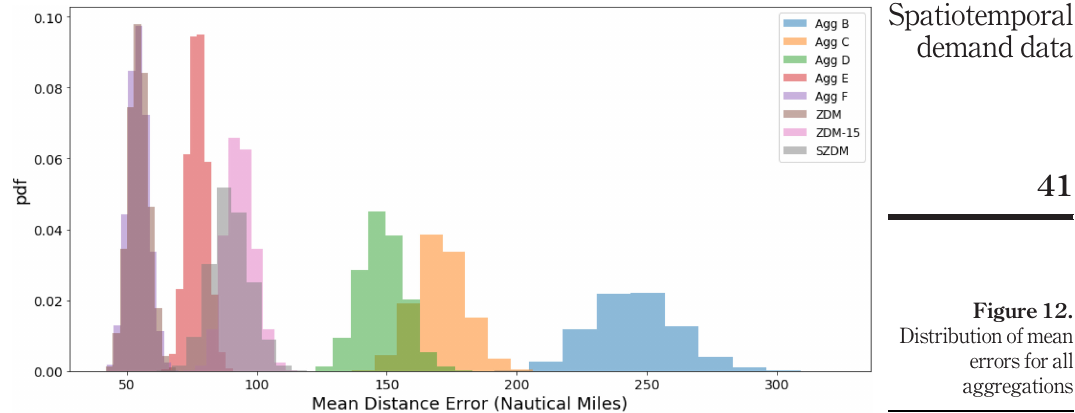
Figure 12. Distribution of mean errors for all